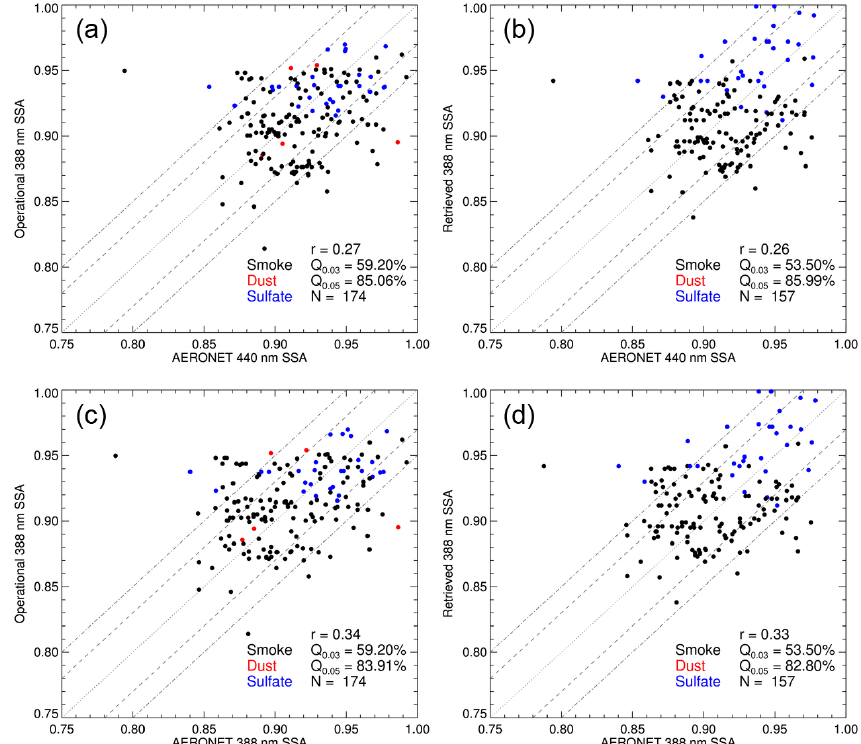
Figure 7. Comparison of the 440nm SSA from AERONET and 388nm SSA from (a) the operational products and (b) the OE-based algorithm, during the DRAGON-NE Asia 2012 campaign. Panels (c) and (d) compare converted 388nm SSA from AERONET with that from (c) the operational products and (d) the OE-based